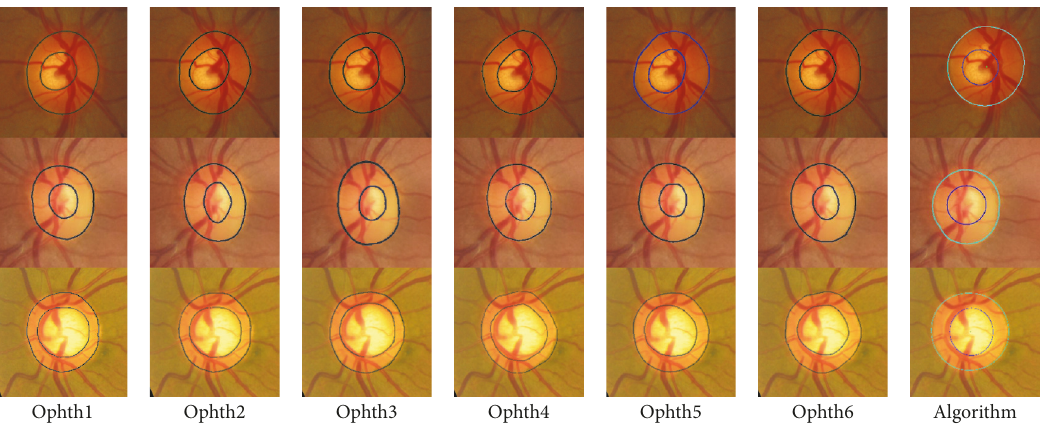
Figure 9: Examples of good segmentation results for vertical cup to disc ratio. Each row shows the results for a sample image. The images on each row show the results of manual markings by the six ophthalmologists (1 to 6) and the automatic marking by the